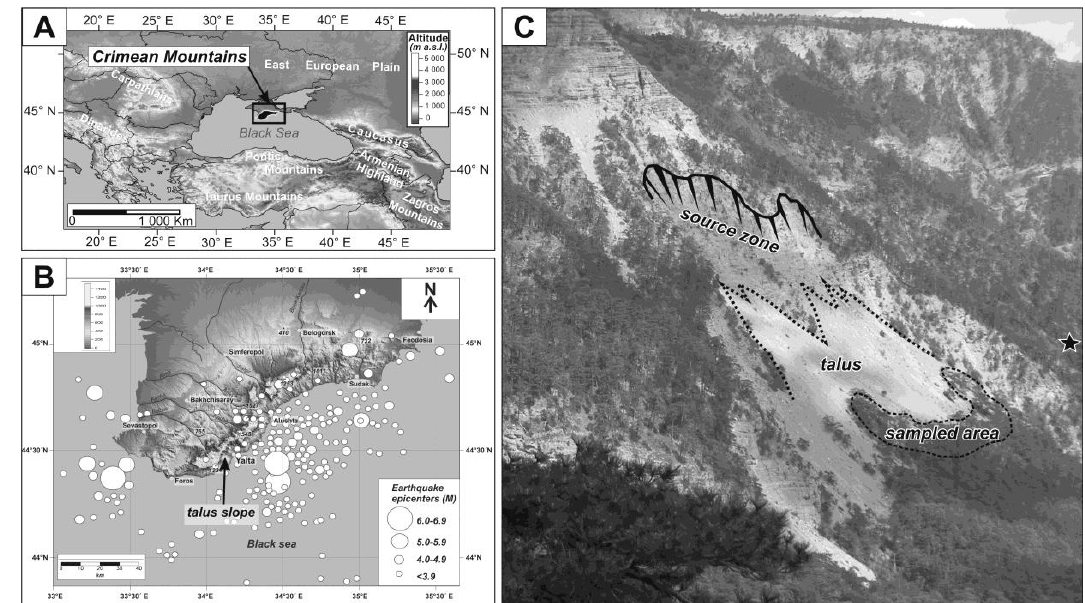
Fig. 1. A – location of the Crimean Mountains. B – location of the talus slope in the vicinity of Yalta and the epicentres of historical Figure 1: A – location of the Crimean Mountains, B – location of the talus slope in the 476 earthquakes. C – detailed view of locality studied (star – position of reference trees). vicinity of Yalta town and the epicenters of historical earthquakes, C – detailed view of 477 locality studied (asterisk – position of reference trees). 478